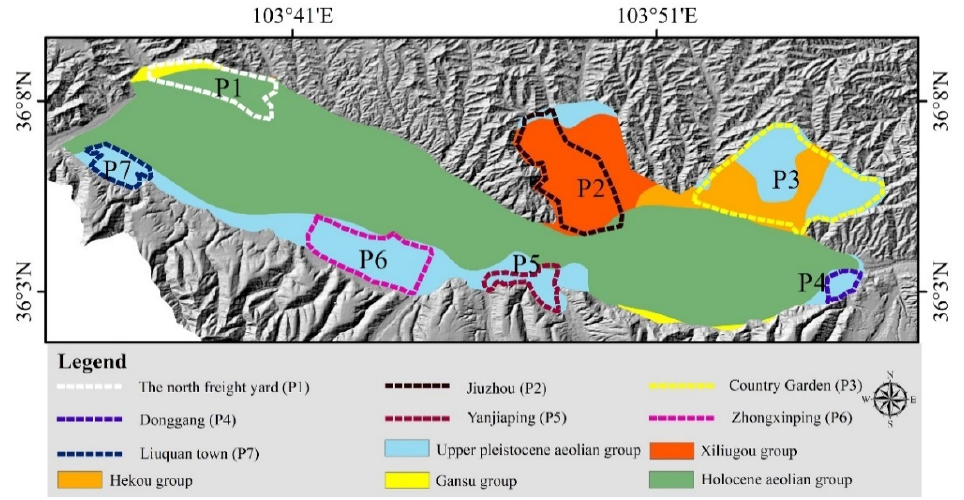
Figure 10. Distribution of the geology in the study area.